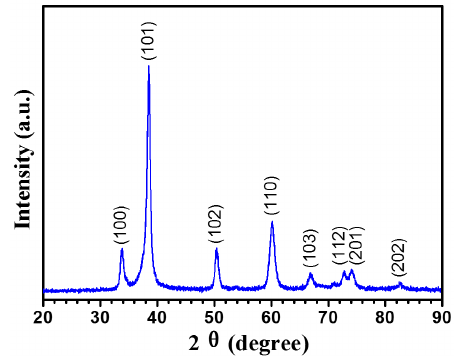
Figure 1. Typical X-ray diffraction pattern taken from the as-deposited Ta 2 N coating.